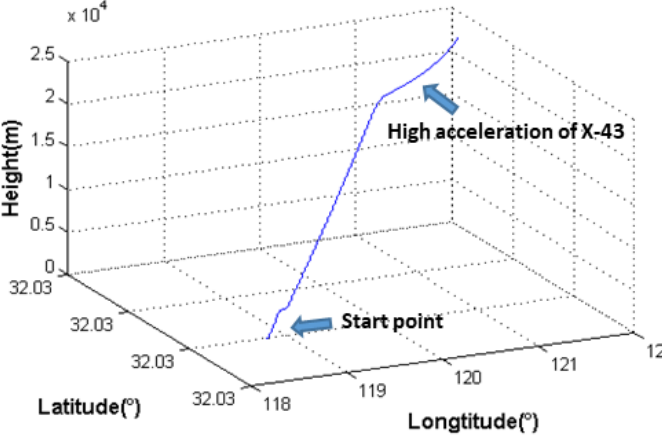
Figure 2. 3D trajectory of the X-43 hypersonic aircraft. Table 2. Parameters of the X- 43 hypersonic aircraft’s dynamic traject ory.